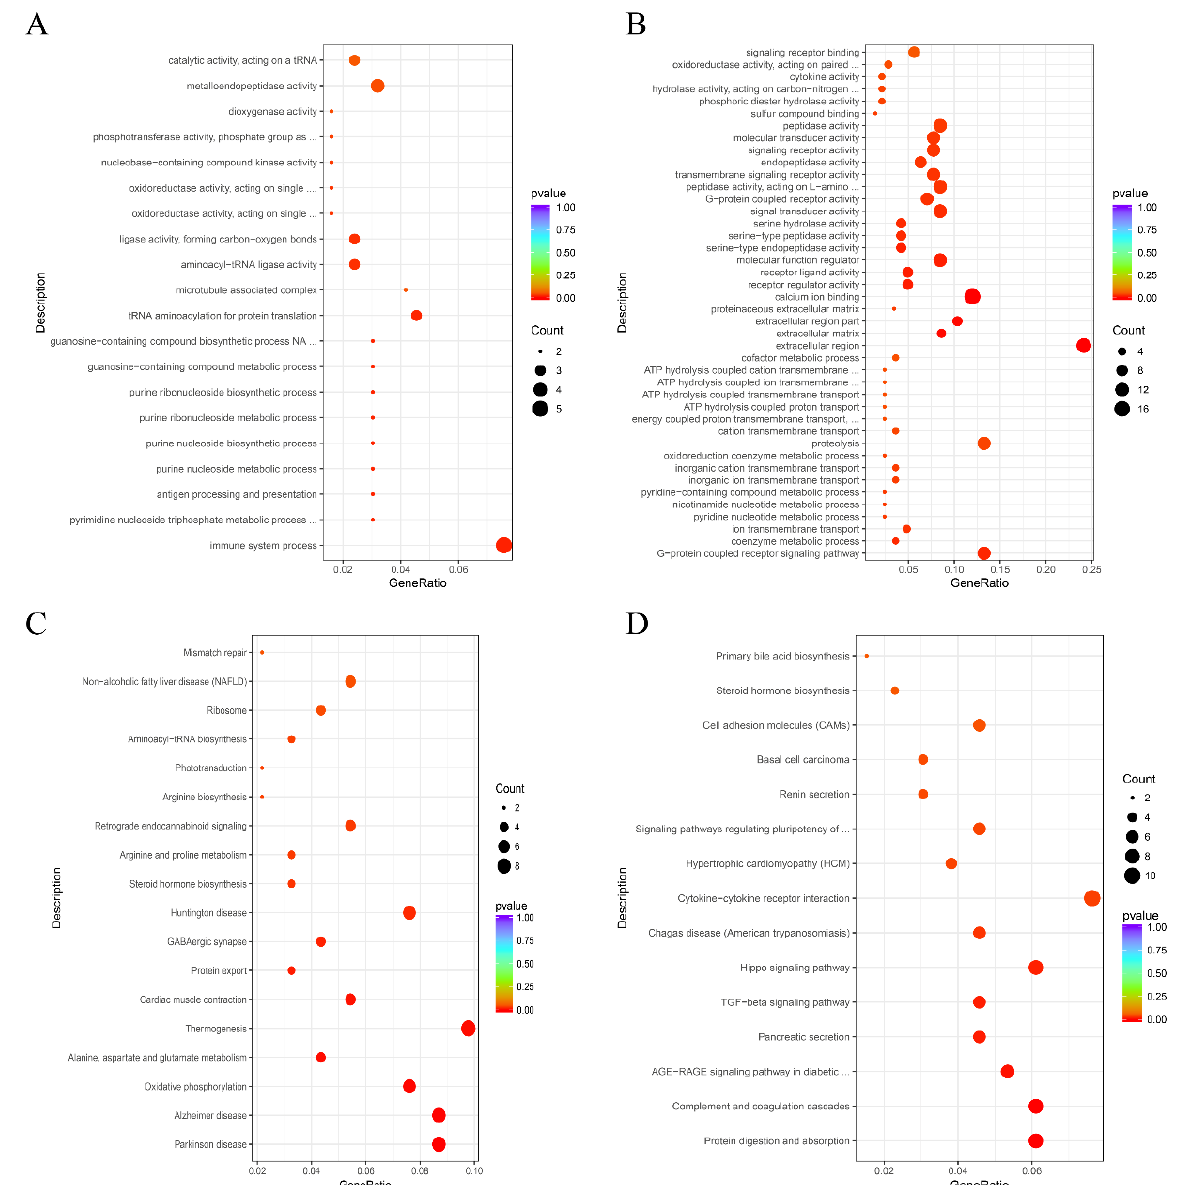
Figure 4. Gene ontology (GO) enrichment analysis of DEGs in the control group and the HS group during embryo implantation. ( A ) Up-regulated DEGs. ( B ) Down-regulated DEGs. Kyoto encyclopedia of genes and genomes (KEGG) analysis of DEGs in the control group and the HS group during embryo implantation. ( C ) Up-regulated DEGs. ( D ) Down-regulated DEGs.